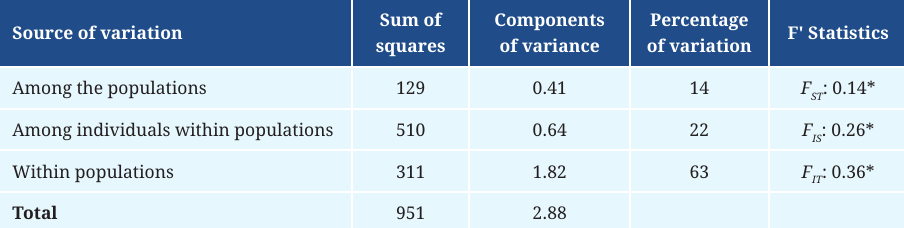
TABLE 1 | Analysis of Molecular Variance (AMOVA) of different groups of Prochilodus lineatus using microsatellite markers. * Statistically significant values p ≤ 0.007.